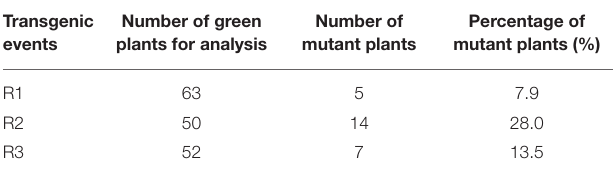
TABLE 3 | The ratio of DXS1 mutants in the green SE plants after genome editing. Transgenic